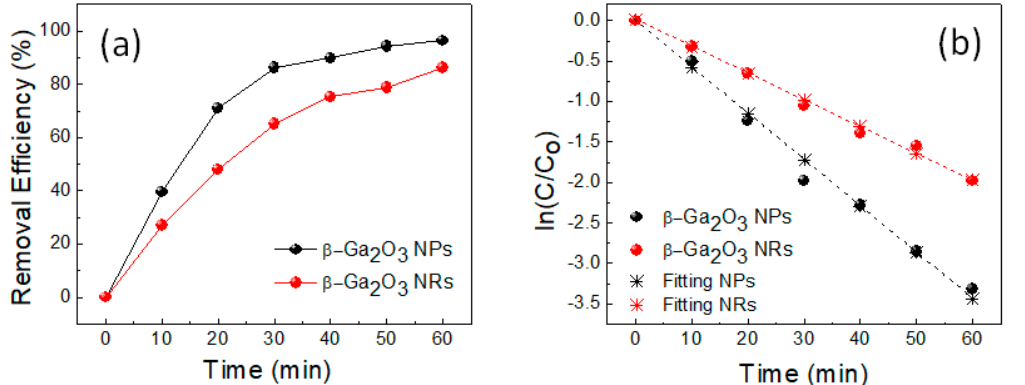
Figure 5. ( a ) HCHO removal efficiency of β‐ Ga 2 O 3 NRs and NPs as a function of UVC irradiation time. ( b ) Langmuir ‐ Hinshelwood pseudo ‐ first order kinetic model for HCHO degradation of β‐ Ga 2 O 3 NRs and NPs under UVC irradiation.